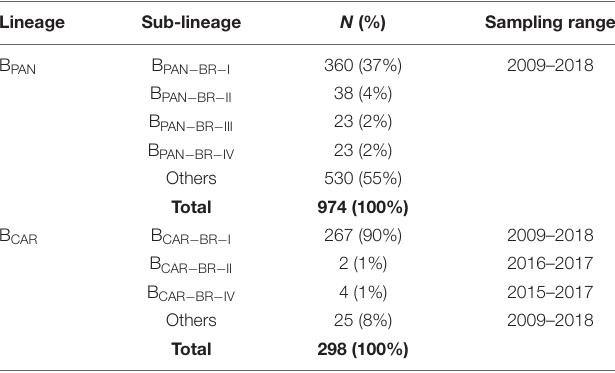
The table details the distribution of 1,272 HIV-1 subtype B pol sequences (nucleotides 2,253–3,275 of reference strain HXB2) from Brazil’s Amazonas state across the known clusterization profile of the pandemic (B PAN , n = 974, 77%) and non-pandemic (B CAR , n = 298, 23%) forms. For each cluster, its absolute and relative frequency of samples from Amazonas state, as well as their distribution in time, are indicated. The class “Other” aggregates sequences not clustered among established major Brazilian